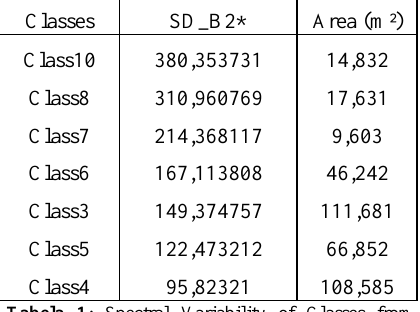
Tabela 1 : Spectral Variability of Classes from Planet Product Green Band * Standard Deviation of Band 2 Values of standard deviation of the green band were chosen for ordering the classes, since this band is expected to have the higher reflectance response to phytoplankton in water for this sensor.